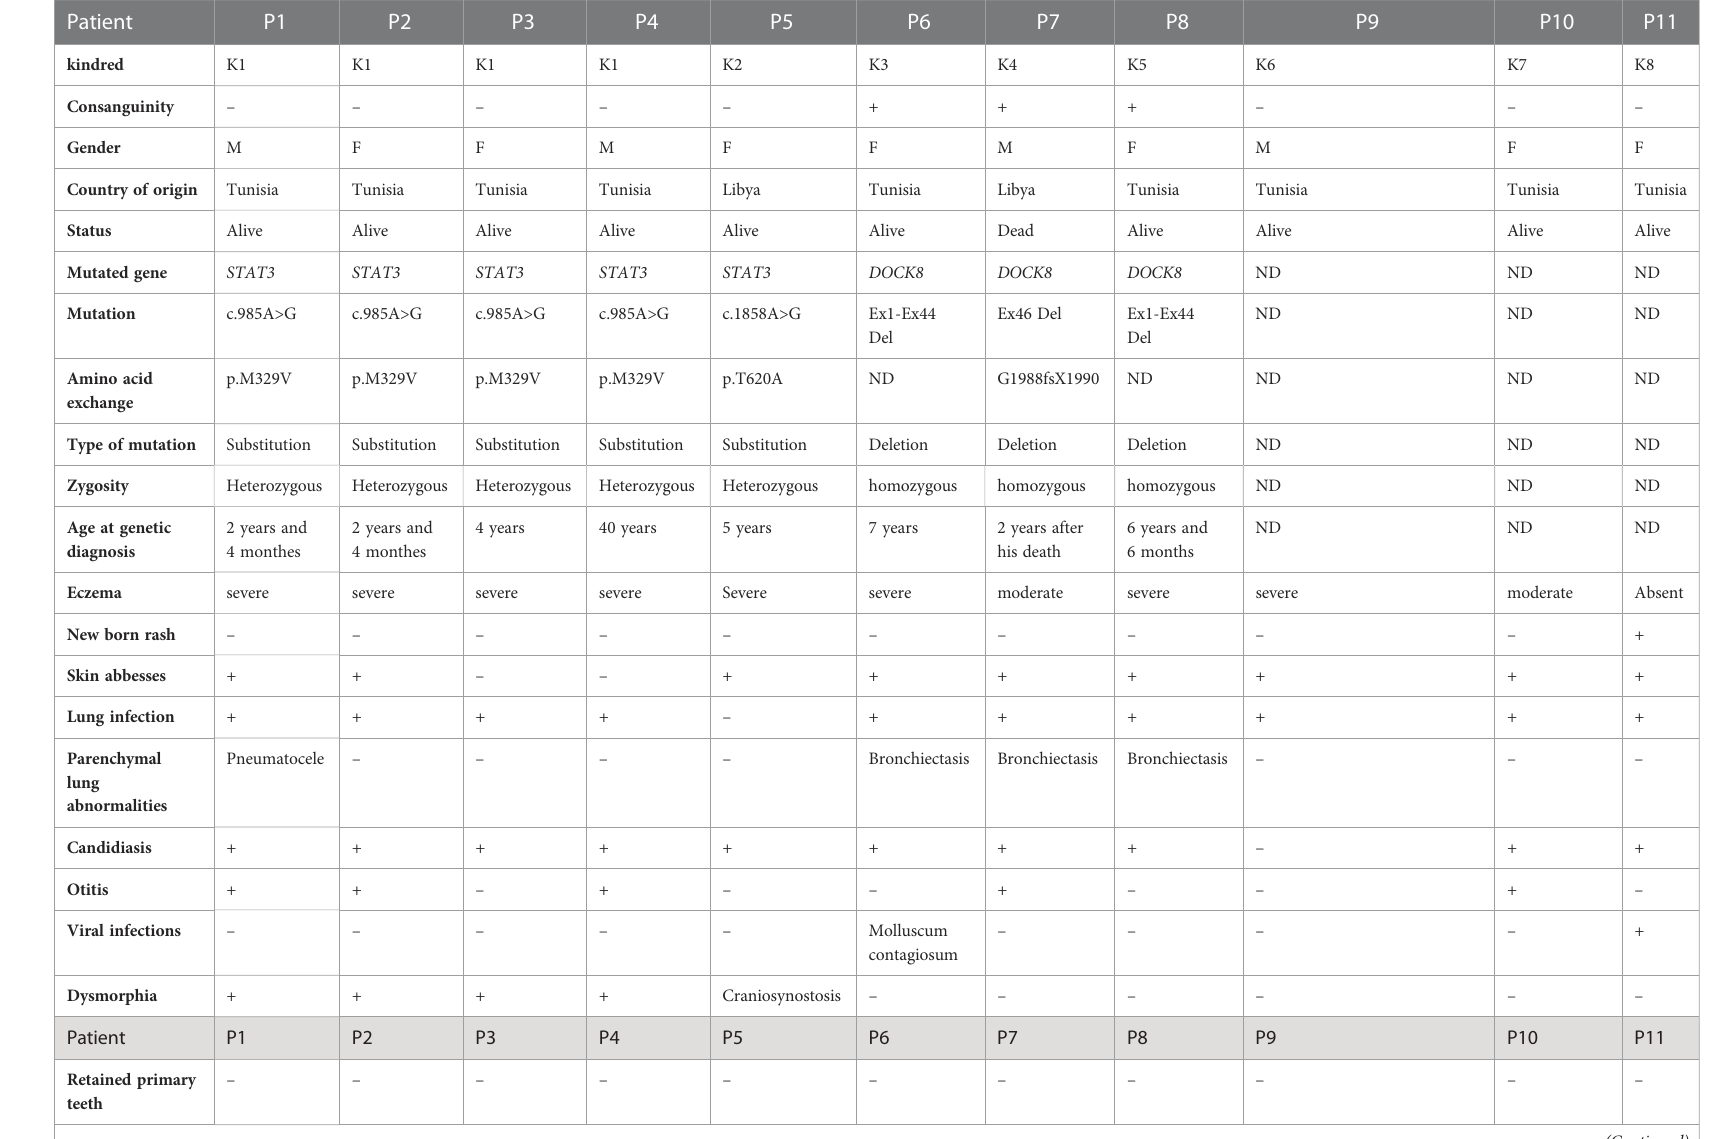
TABLE 1 Clinical and genetic fi ndings in patients with Hyper IgE Syndromes.